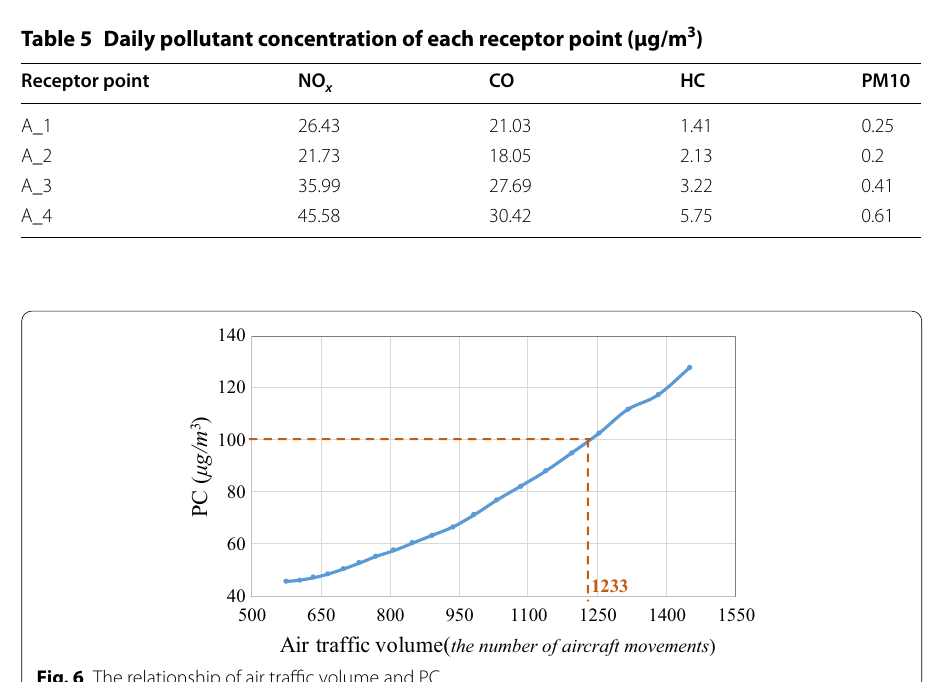
Fig. 6 The relationship of air traffic volume and